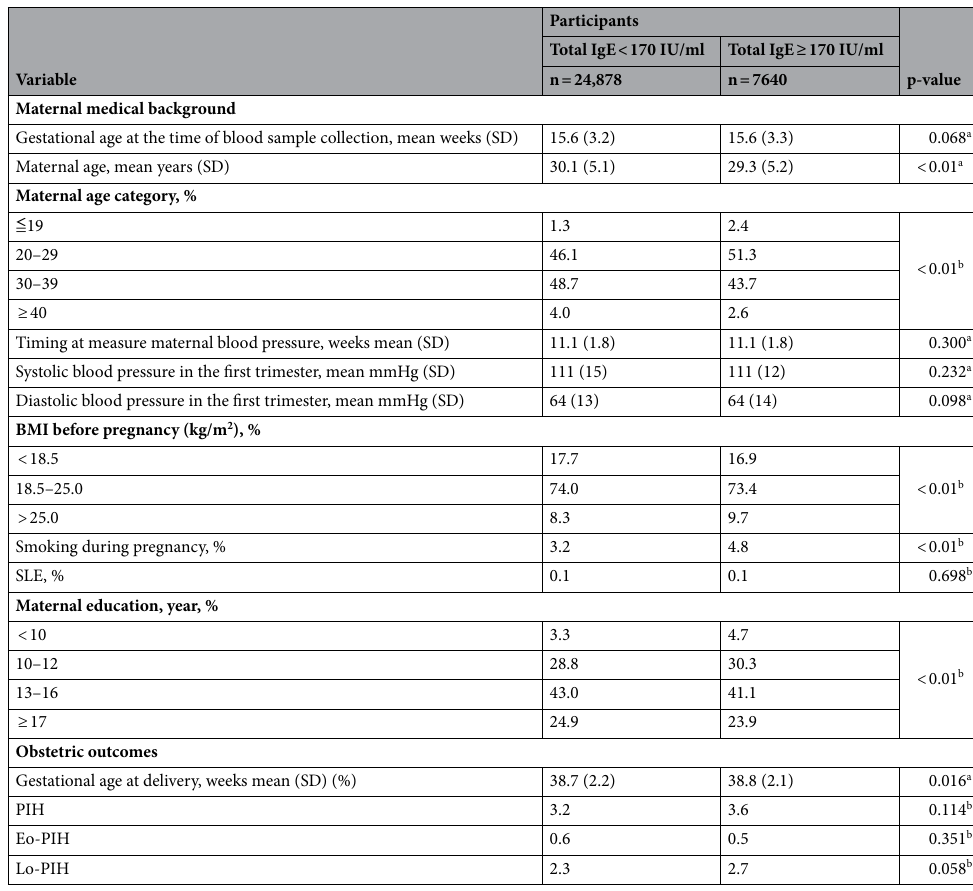
Table 1. Maternal background and obstetric outcomes based on serum IgE levels. IgE immunoglobulin E, SD standard deviation, BMI body mass index, SLE systemic lupus erythematosus, PIH pregnancy induced hypertension, Eo early-onset, Lo late-onset. a p-value, t-test. b p-value, chi-square